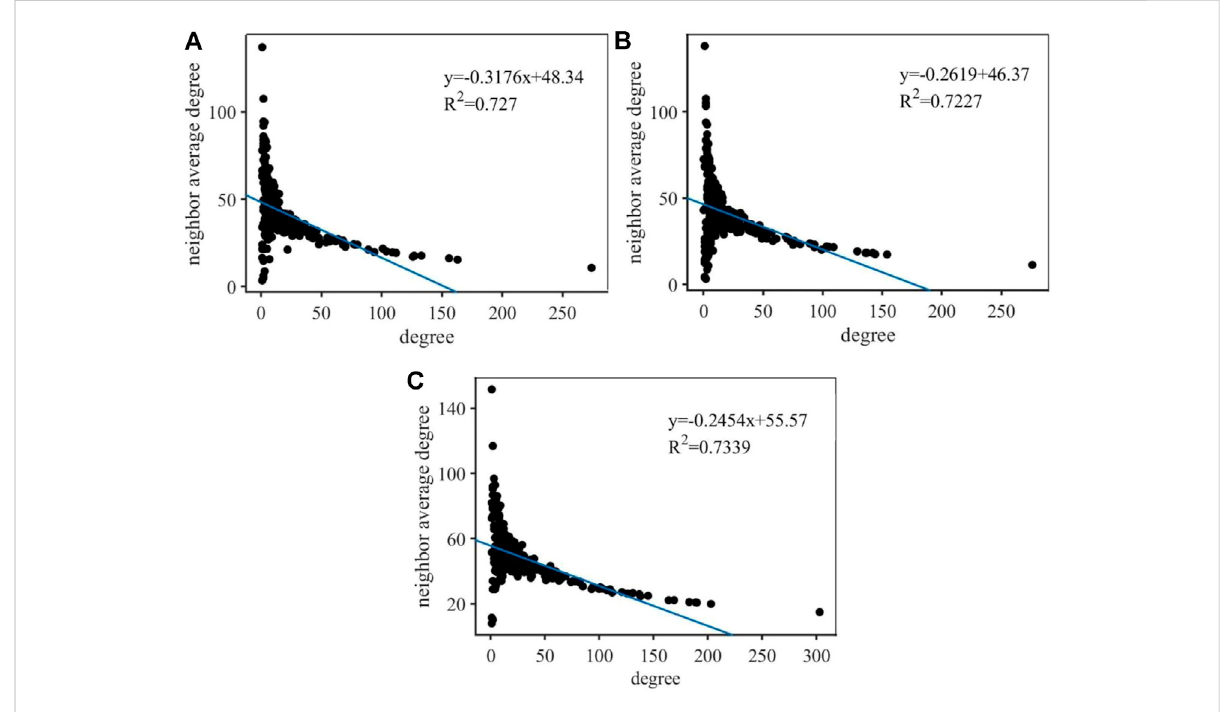
Degree correlation of urban innovation networks: (A) 2017; (B) 2018; and (C)